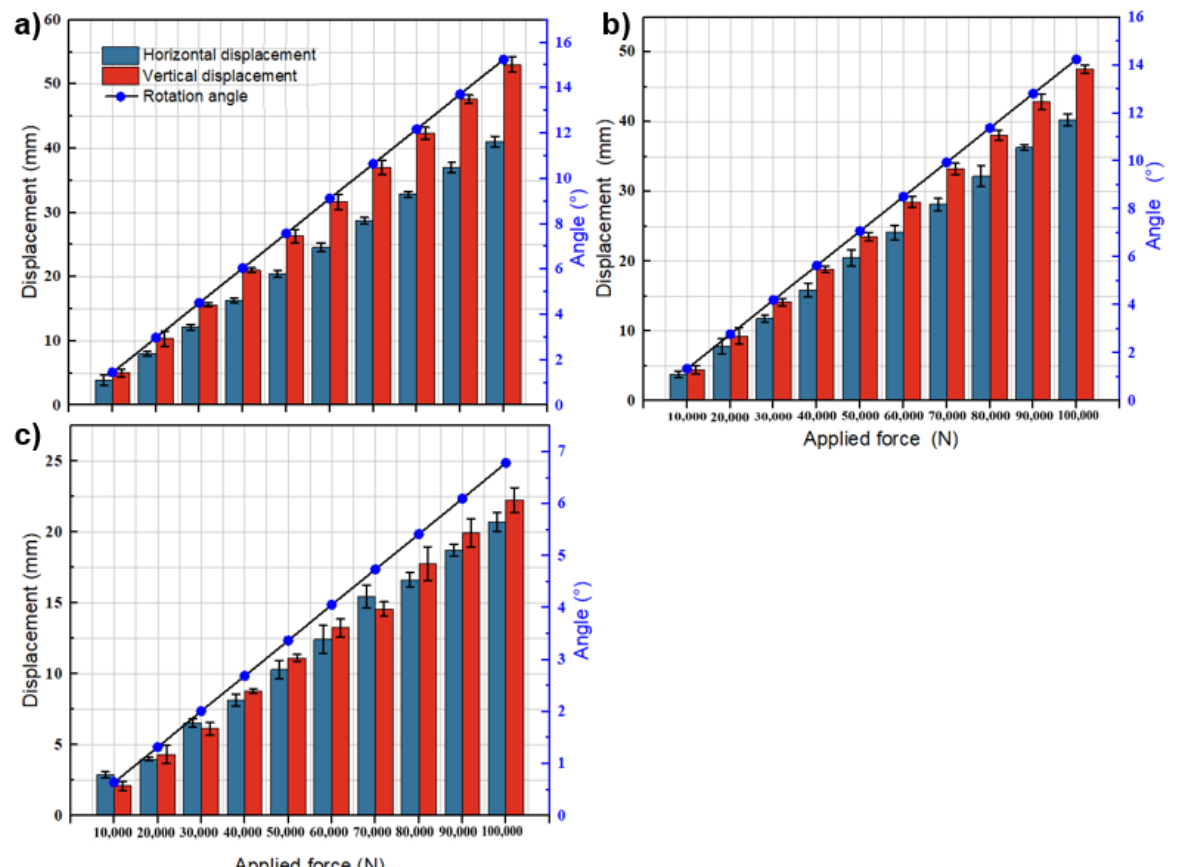
Figure 6. ( a ) Results of central deformation of swing arm under the shaft tube swing arm semi-rigid suspension; ( b ) Results of central deformation of swing arm under the fish-bellied swing arm semi- rigid suspension; ( c ) Results of central deformation of swing arm under the fish-bellied swing arm torsion bar suspension.